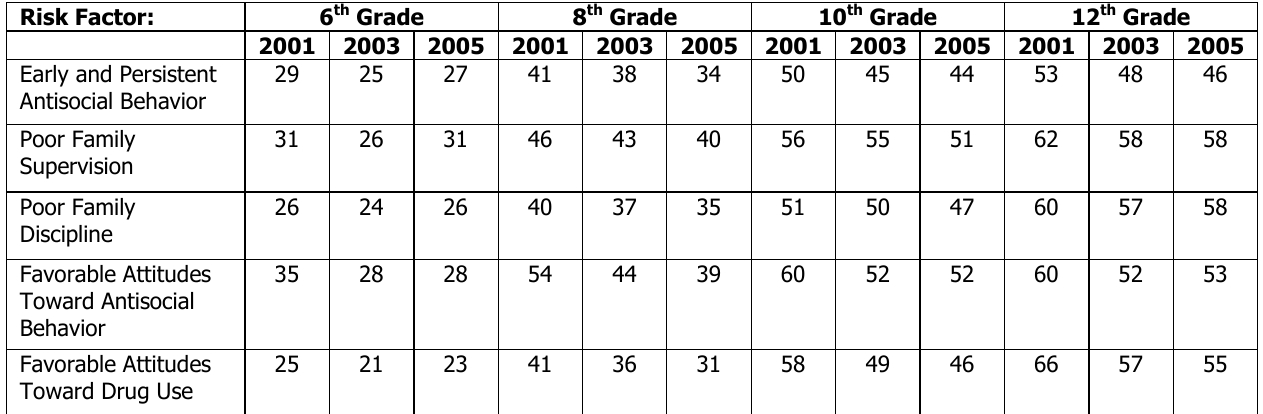
Normalized risk factor scores by grade